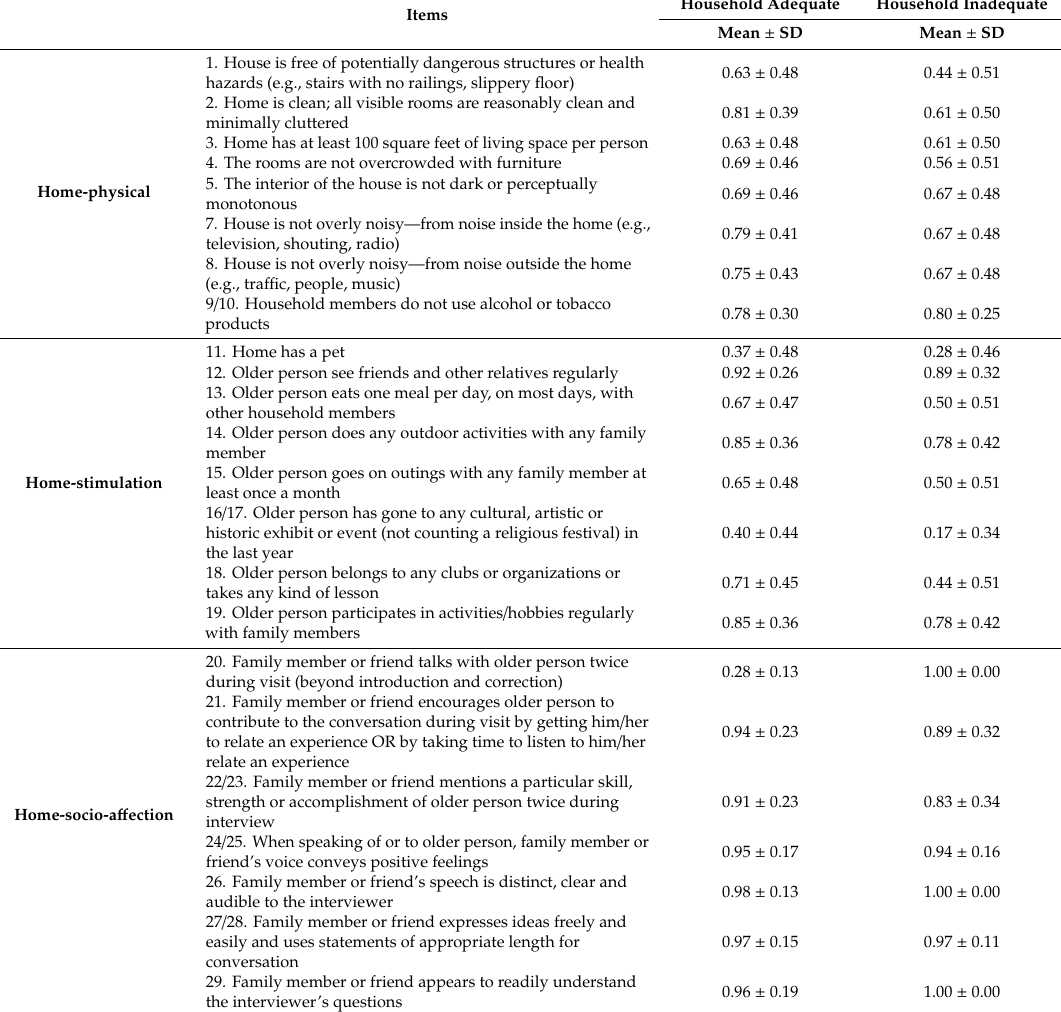
Table 4. Means for each HOME item by adequate / inadequate household based on S-IQCODE